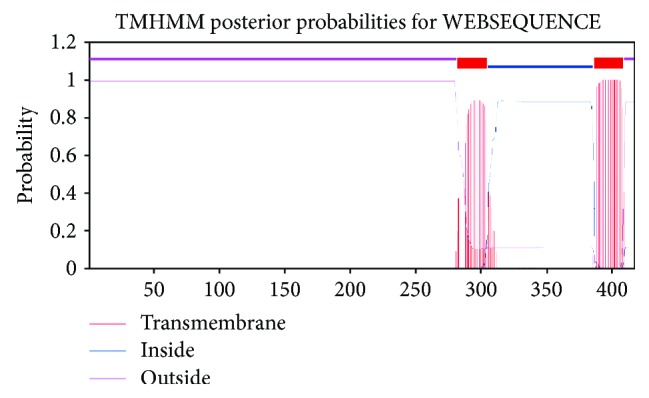
TMPRED and TMHMM predictions for transmembrane proteins. Two transmembrane regions (285-301 and 389-408) displayed a probability ≥ 0.8 and a score that exceeded 500, strongly indicating the presence of transmembrane domains.